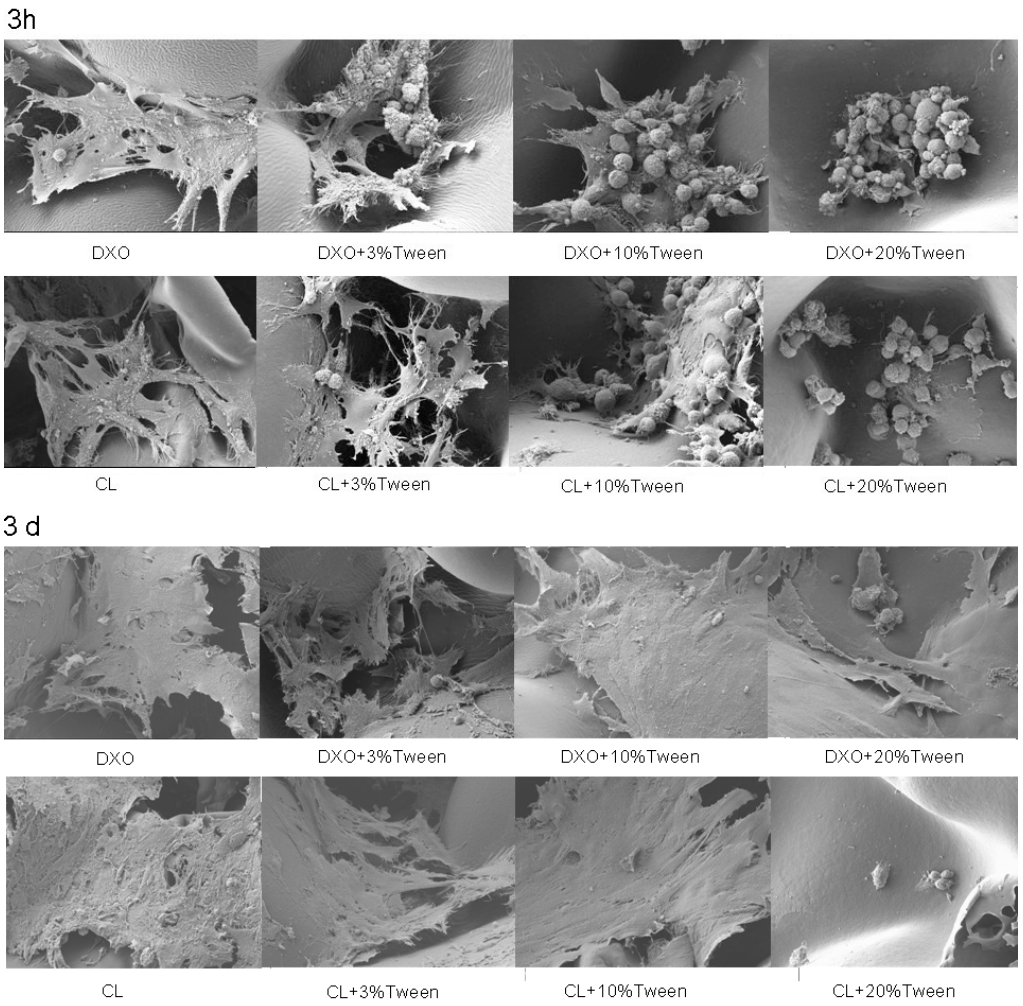
Figure 5. SEM results after 3 h and 3 days. Results from 3 h showed the better spreading of hMSCs on control groups compared with the Tween 80-added groups. Three days’ results showed that most cells could spread and grow from the control groups and the 3% and 10% Tween 80-added groups. Fewer cells could be observed in the 20% Tween 80-added groups.